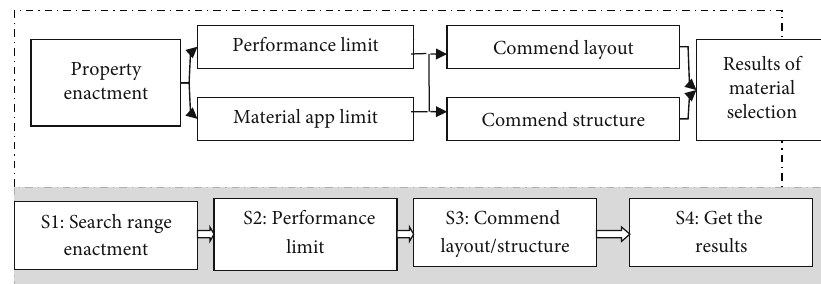
Figure 4: Methods of material selection: performance limit.